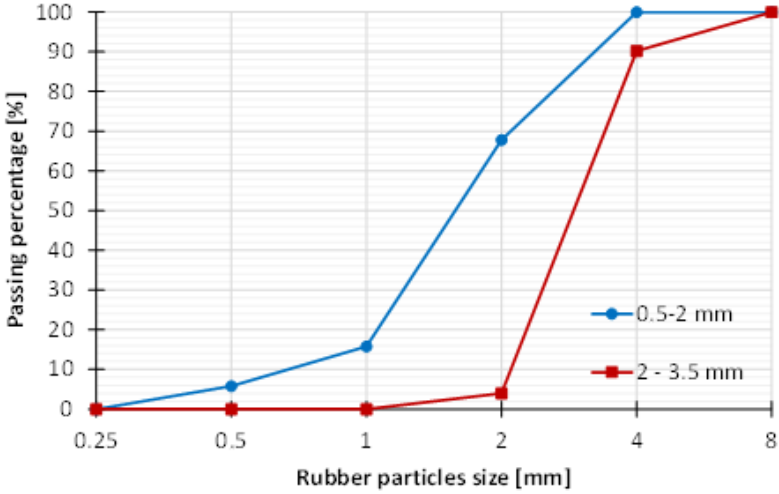
Figure 4. Particle size distribution of crumb rubber aggregate.